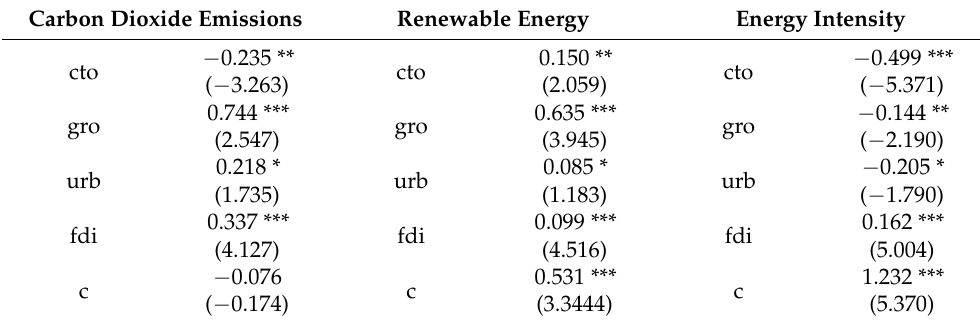
Table 5. Results of long-run